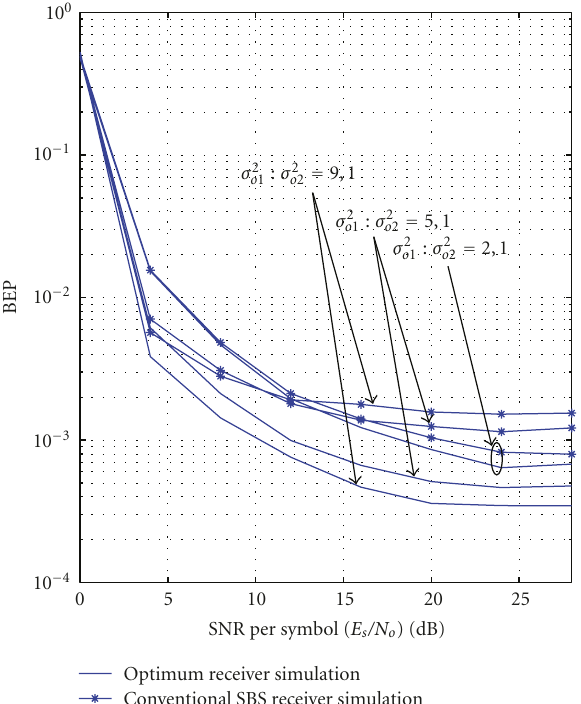
Figure 4: Case 2: BEP results for the conventional SBS and the optimum receivers, 2Tx and 2Rx Alamouti’s code with QPSK modulation, f d T b = 0 .